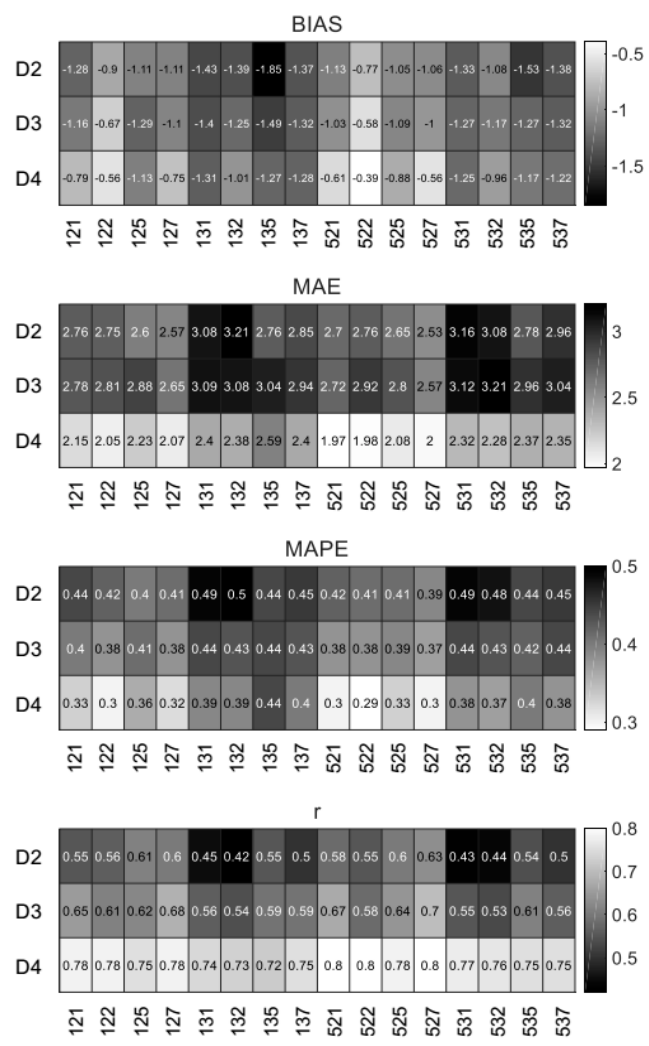
Figure 6. Panels of BIAS, MAE, MAPE, and r calculated for di ff erent domains (D2, D3, and D4) and physical schemes.